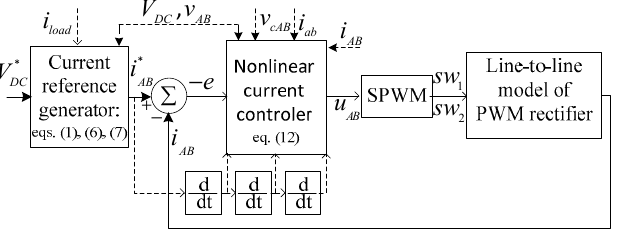
Figure 3. The proposed control scheme for the line-to-line v AB circuit.